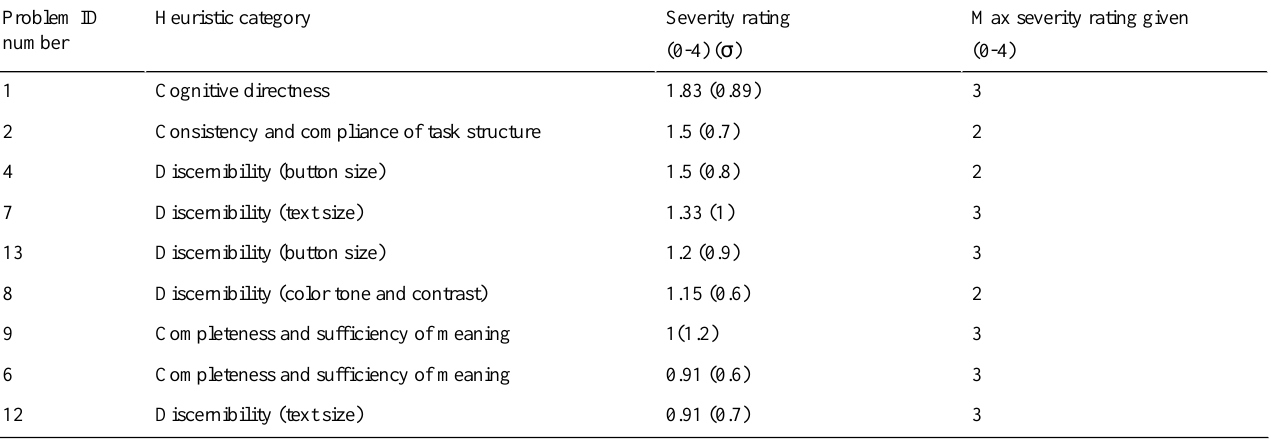
Table 7. Problems uncovered by end users and rated based on mean Likert